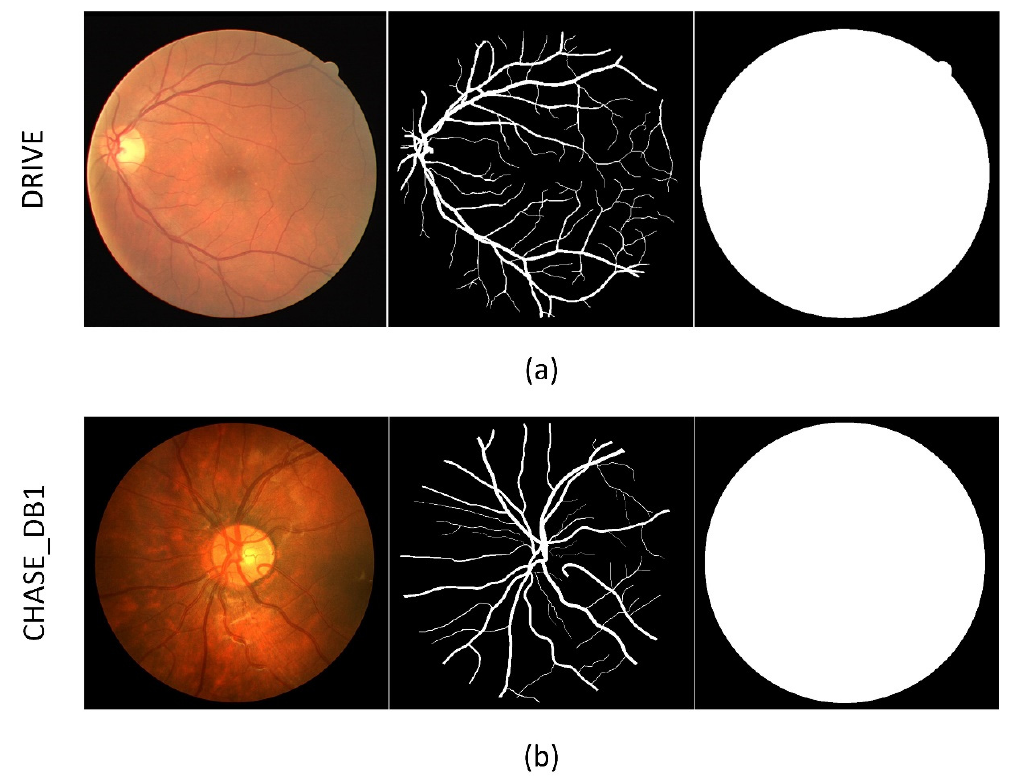
Figure 5. ( a ) DRIVE dataset and ( b ) CHASE_DB1 dataset. Looking from left to right, the leftmost column is the original image, the middle column is the corresponding ground truth, and the rightmost column is the corresponding mask.